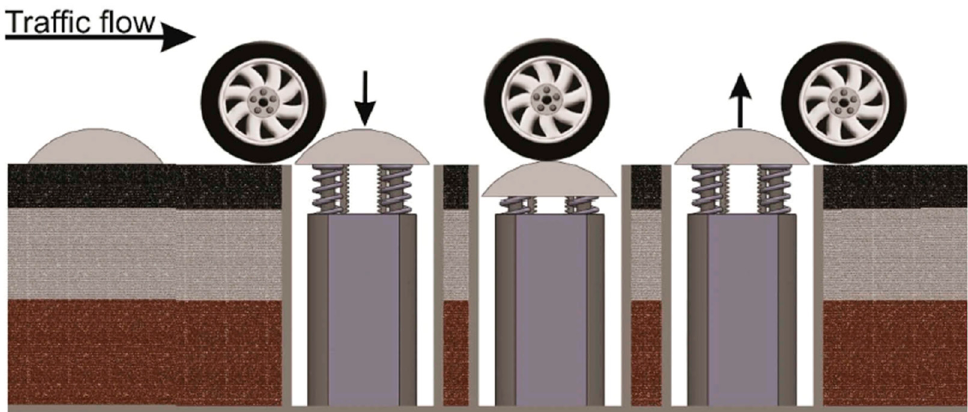
Figure 2. Section of a vertical rack and pinion EH under a speed bump as a wheel approaches, passes, and leaves (Reprinted with permission from Ref. [26]. 2020, Taylor & Francis) [26].